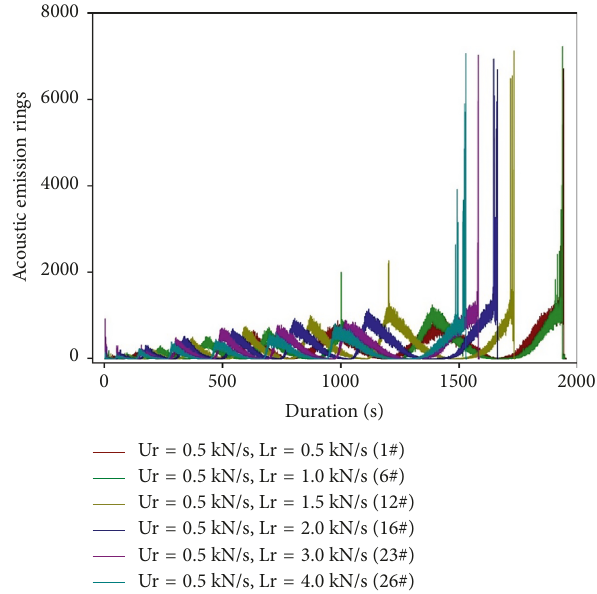
Figure 6: Changes of rock AE rings with the monitoring time under the uniaxial cyclic loading and unloading